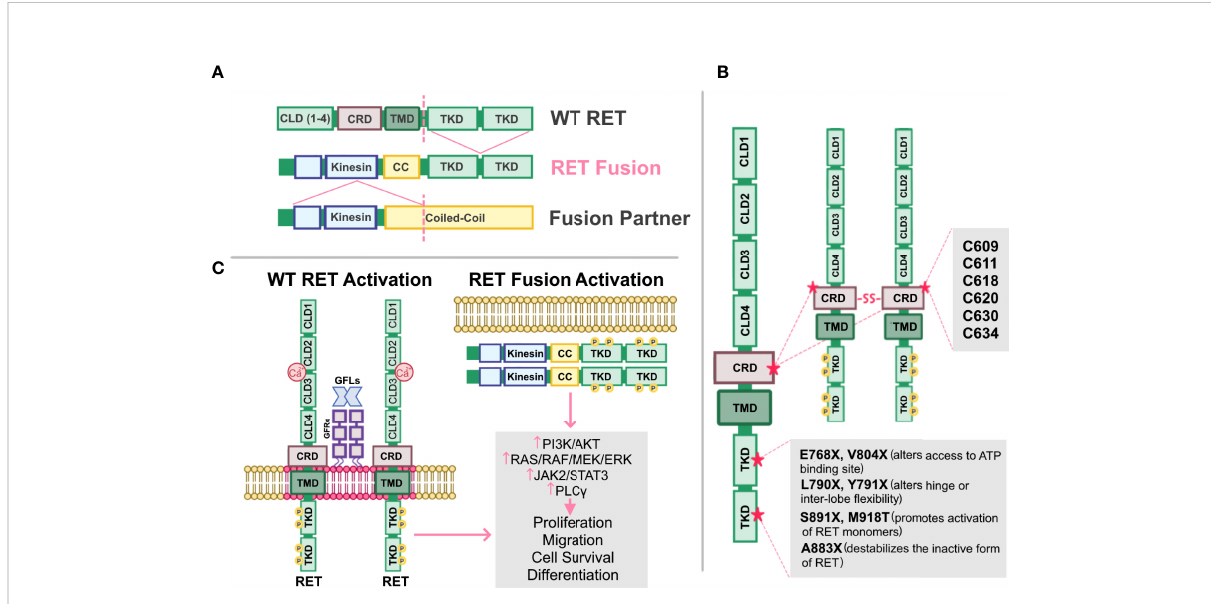
FIGURE 2 Altered RET and their mechanisms of activation. (A) Schematic representation of the fusion between the tyrosine kinase domain of wild-type (WT) RET receptor, and the kinesin and coiled-coil (CC) domain of a fusion partner. Dashed lines represent fusion sites. (B) Cysteine mutations in RET cysteine-rich domain (CRD) promote formation of intermolecular disul fi de bridges, leading to constitutive dimerization and activation of RET that is GDNF-independent. Mutations in RET tyrosine kinase domains (TKD) can elicit steric conformations that regulate access to the ATP binding pocket of RET (E768X, V804X), alter hinge or inter-lobe fl exibility (L790X, Y791X), promote activation of RET monomers (S891X, M918T), or destabilize the inactive form of RET (A883X), all of which confer constitutive RET activation albeit with varying activities. (C) Activation of either WT RET or oncogenic RET fusions can promote activation of downstream pathways, PI3K/AKT, RAS/RAF/MEK/ERK, JAK2/STAT3, and PLC g resulting in enhanced proliferation, migration, cell survival and differentiation, ultimately promoting neoplastic growth and